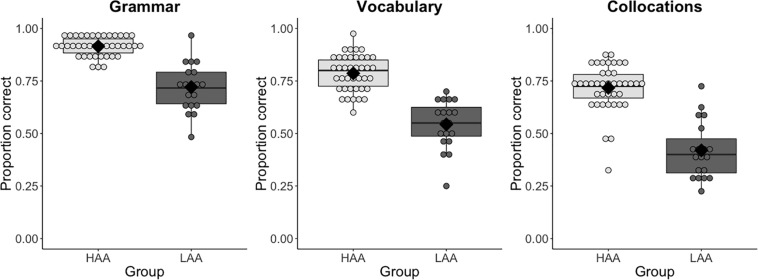
Proportion of correct responses in the Grammar (left), Vocabulary (center), and Collocations (right) tasks by Group (LAA – in dark gray; HAA – in light gray). Dots showcase the distributions of individual values within each group and the black diamonds signal group means.